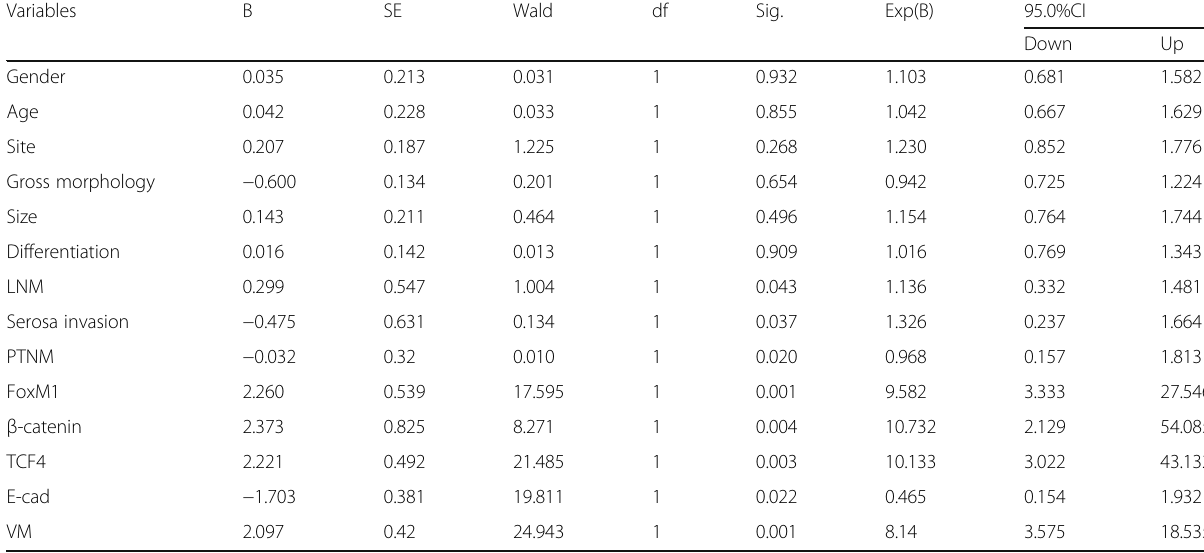
Table 4 Multivariate survival analysis of patients with ESCC ( n = 216) Variables